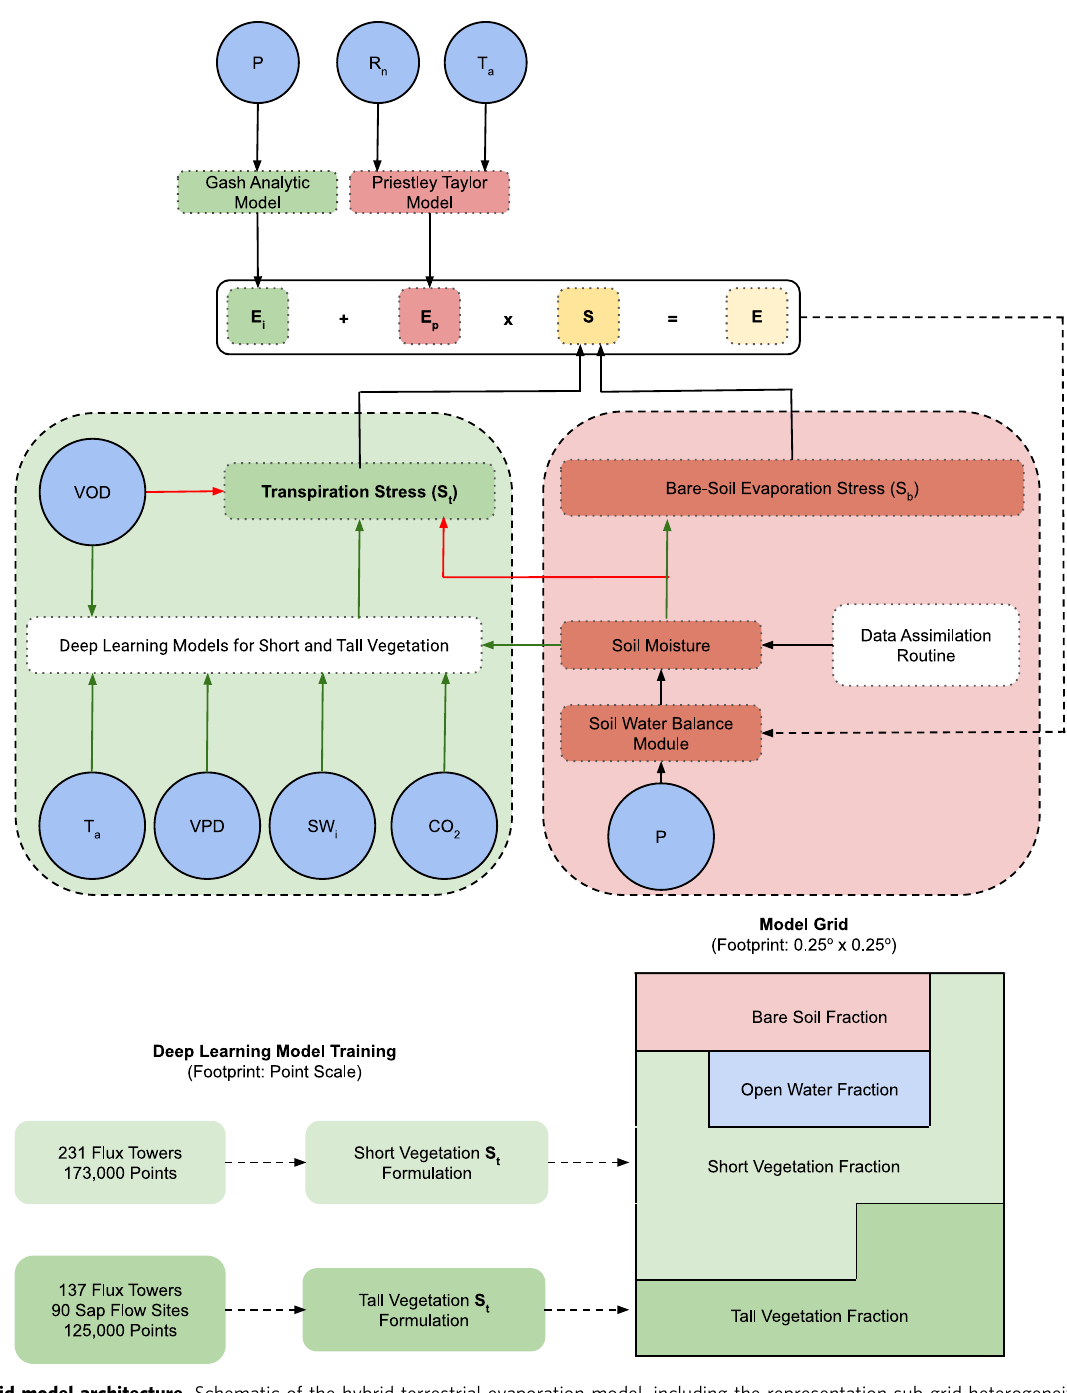
Fig. 1 Hybrid model architecture. Schematic of the hybrid terrestrial evaporation model, including the representation sub-grid heterogeneity and the difference in the footprints of the deep learning model and the hybrid model. E i is interception, E p is potential evaporation, S is the evaporative stress factor, S E is actual evaporation, P is precipitation, R T VOD is vegetation optical depth, VPD is vapor t is transpiration stress, n is net radiation, a is air temperature, pressure de fi cit, SW i is incoming shortwave radiation, and CO 2 is carbon dioxide. The red arrows indicate modeling steps which are exclusive to the processed-based model, the green arrows are steps which have been added in the hybrid, and the black arrows are steps common to both the